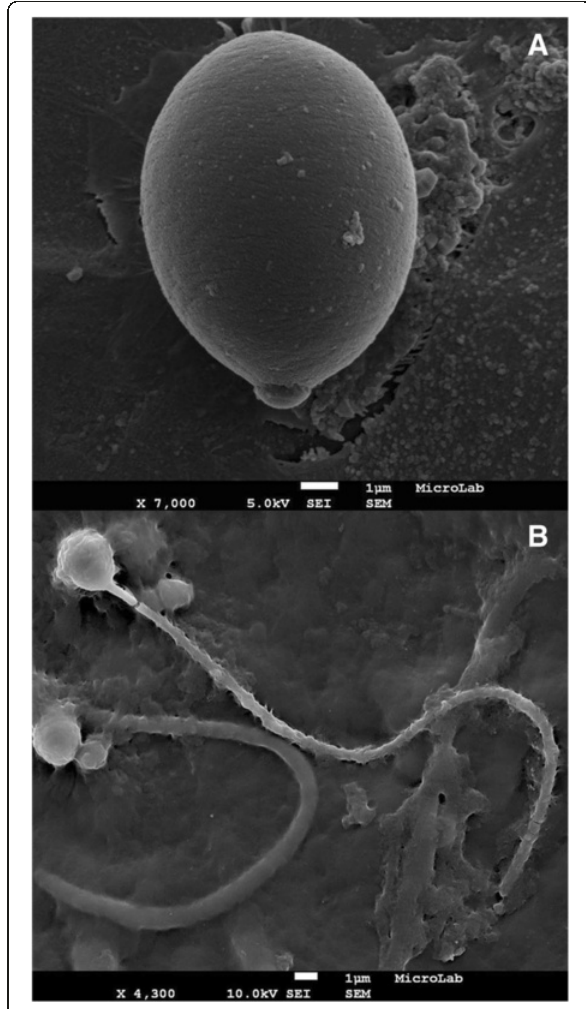
Fig. 2 Nematocytes of C. tagi viewed through SEM. a Intact cell. b After nematocyst discharge; possibly an atrichous isorhiza ( left ) and a birhopaloid ( right ). Bars: 1 μ